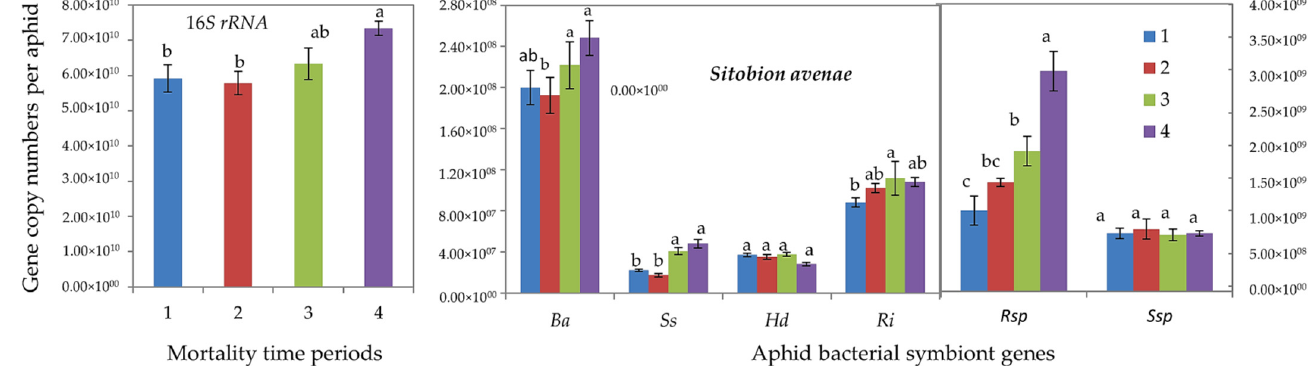
Figure 3. Abundance (mean gene copy numbers ± SD; n = 20) of bacterial symbionts of aphids ( Sito- bion avenae ) under chronic exposure to 31 ◦ C. Dead aphid individuals were divided into four mortality time periods, i.e., 1–4, representing susceptible-to-tolerant thermal threshold levels. 16S rRNA = total eubacterial rDNA gene; Ba = Buchnera aphidicola ; Ss = Serratia symbiotica ; Hd = Hamiltonella defensa ; Ri = Regiella insecticola ; Rsp = Rickettsia spp.; Ssp = Spiroplasma spp. Different letters at the tops of the treatment bar show significant differences between treatments (one-way ANOVA; p ≤ 0.05).